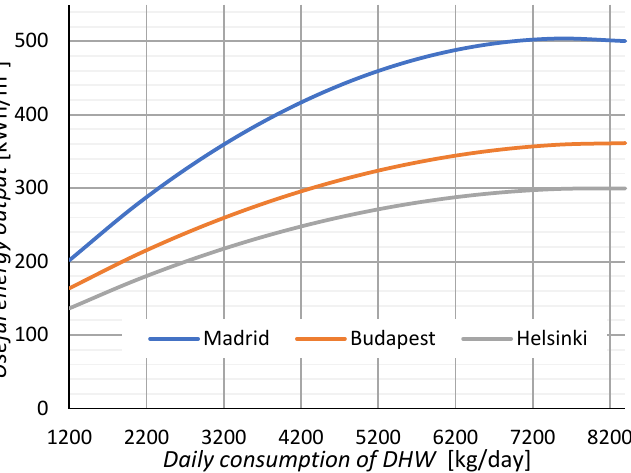
Figure 11. Dependence of the daily consumption of DHW on an annual useful energy output.